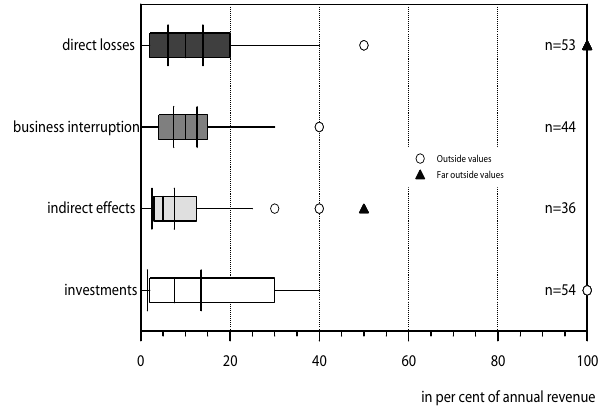
Fig. 3. Boxplot of direct losses, business interruption, indirect losses and investments in % of annual revenue based on companies’ esti- mates. Please note that all given values >100% have been changed to 100 (seven cases).